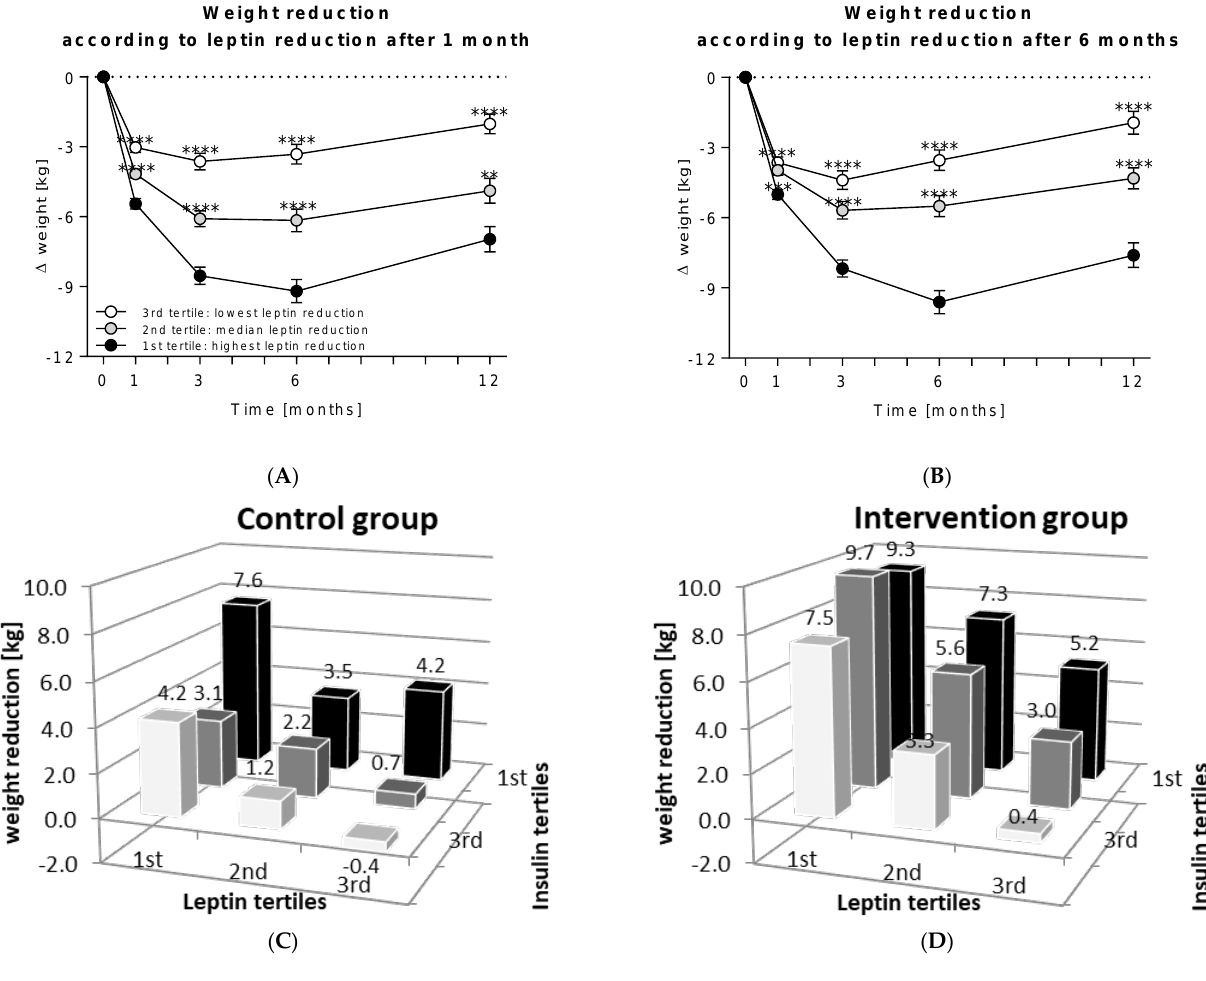
Figure 4. Participants of the intervention group ( n = 293) were divided into three tertile groups according to their relative reduction ( A ) of leptin after 1 month (1st tertile = highest leptin reduction ( n = 98); 2nd tertile = median leptin reduction ( n = 97); 3rd tertile = lowest leptin reduction ( n = 98)) and ( B ) of leptin after 6 months. Weight reduction was compared between tertile groups using Mann Whitney test with the 1st tertile as reference for each (**, p < 0.01; ***, p < 0.001; ****, p < 0.0001). The three leptin tertile groups were additionally stratified according to their insulin reduction after 6 months (1st tertile = insulin reduction of >2 µ U/mL; 2nd tertile = constant insulin values with changes ≤ 2 µ U/mL; 3rd tertile = insulin increase > 2 µ U/mL) and weight reduction is shown ( C ) the control and ( D ) the intervention